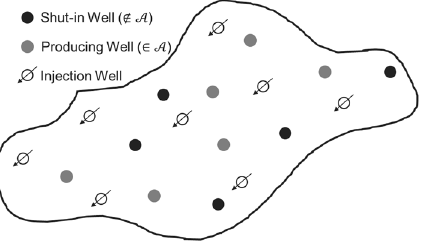
Fig. 2 Schematic representation of an arbitrary reservoir at time step t k where active and shut-in producers are depicted with gray and black,